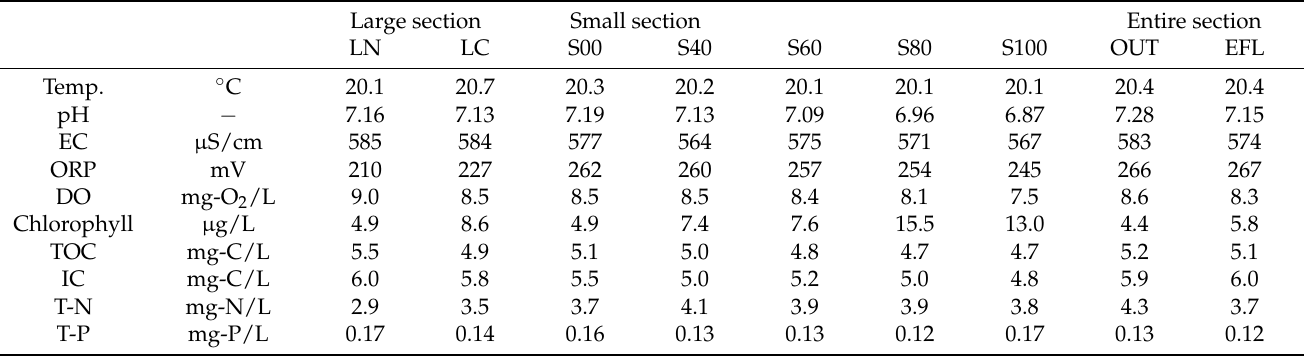
Table 2. Average values of water quality parameters ( n =